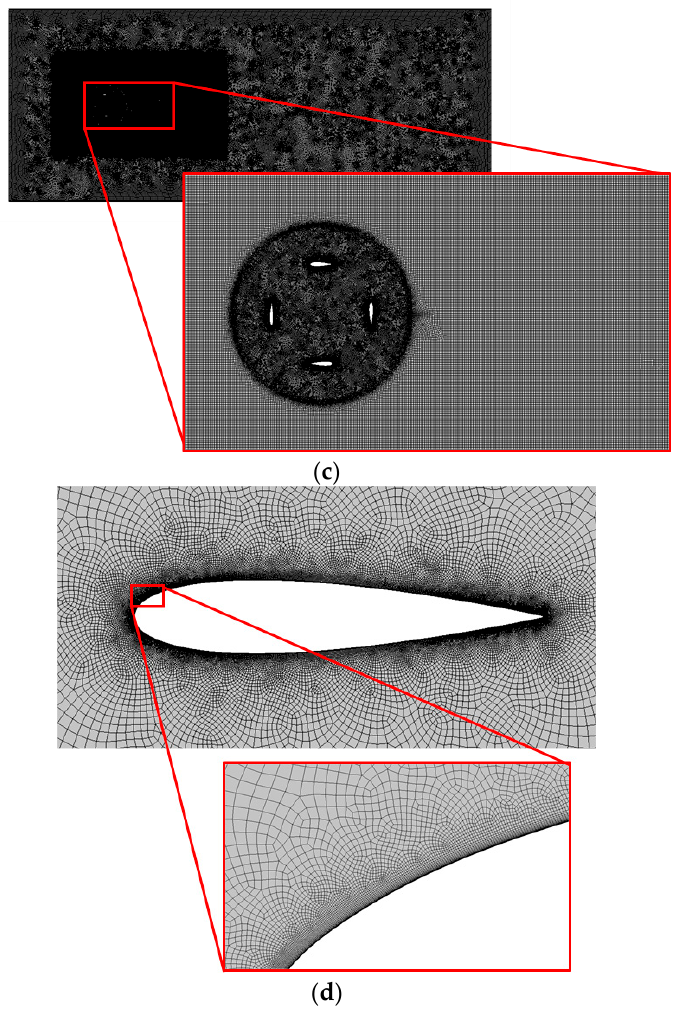
Figure 4. 2D geometry of vertical wind turbine and mesh system; ( a ) 2D flow field geometry including four blades, ( b ) blades position 2D vertical wind turbine, ( c ) mesh system of 2D flow field, and ( d ) mesh system of near the Blade 1.